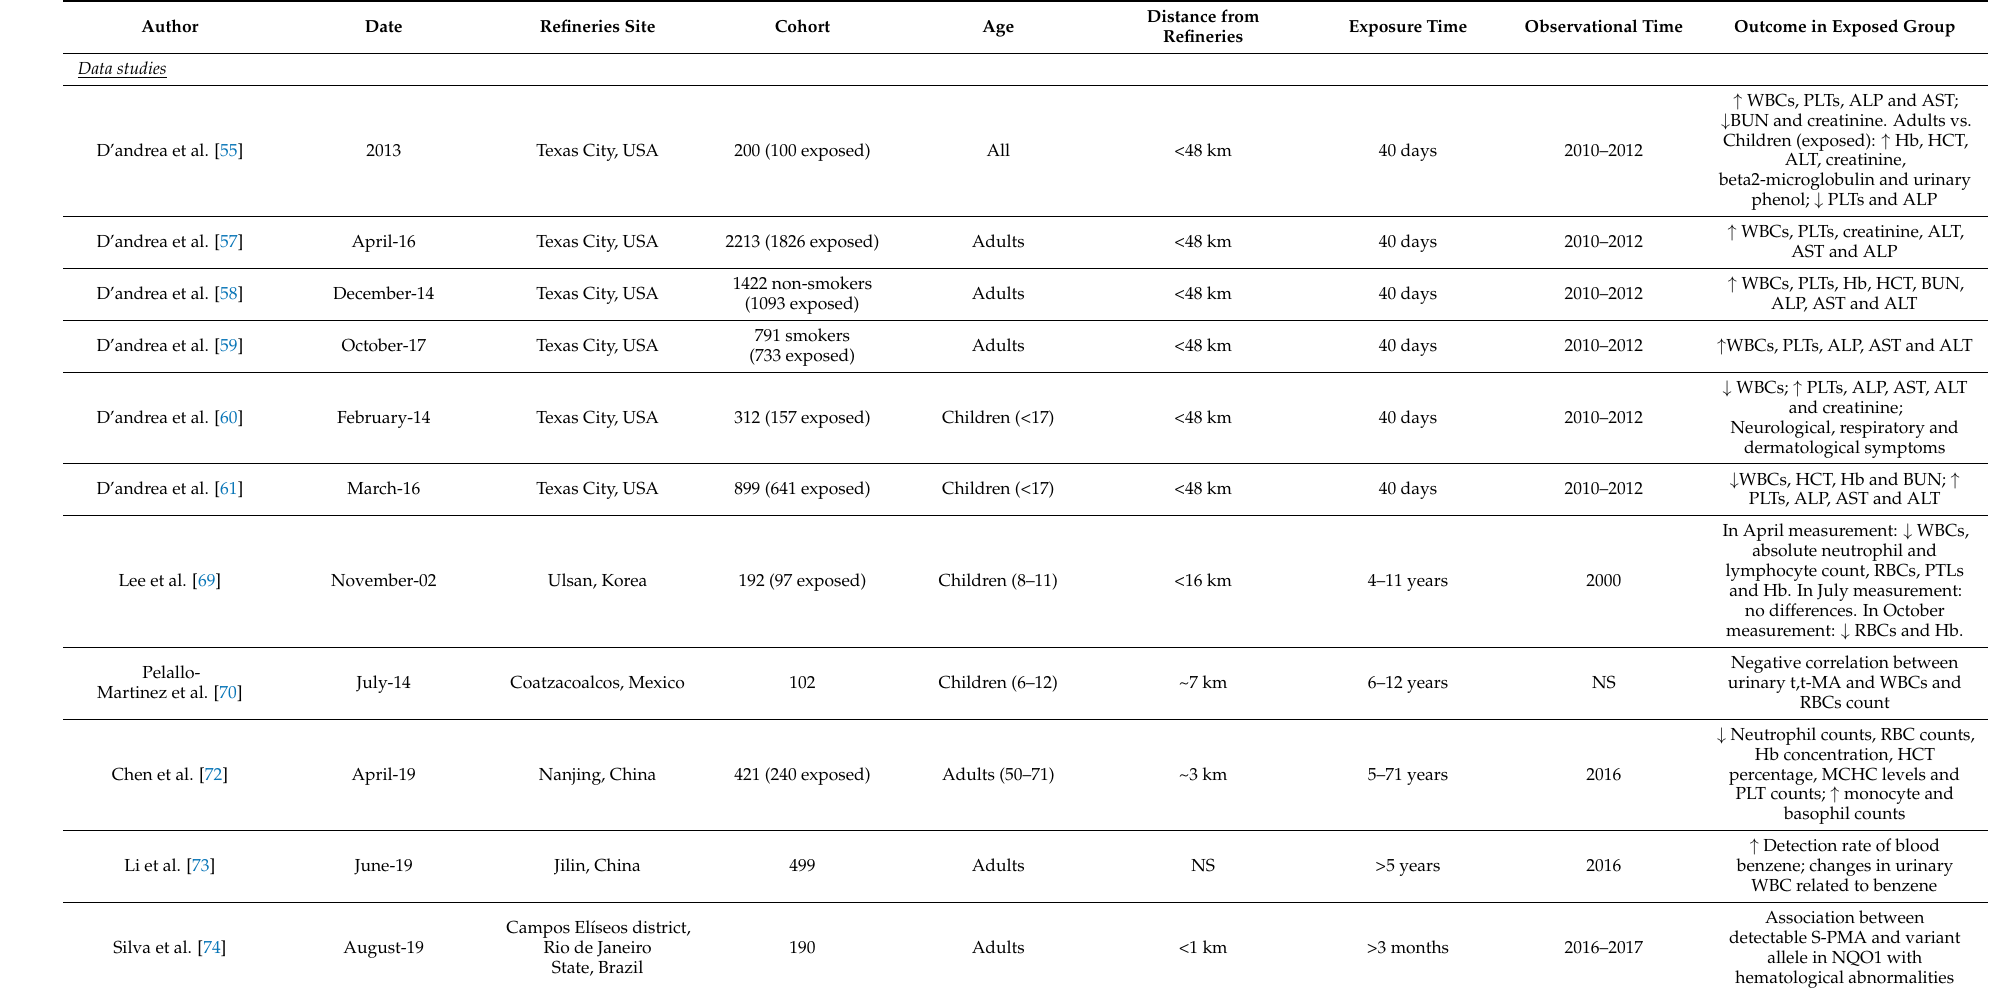
Table 1. Main hematological studies and their characteristics found through our